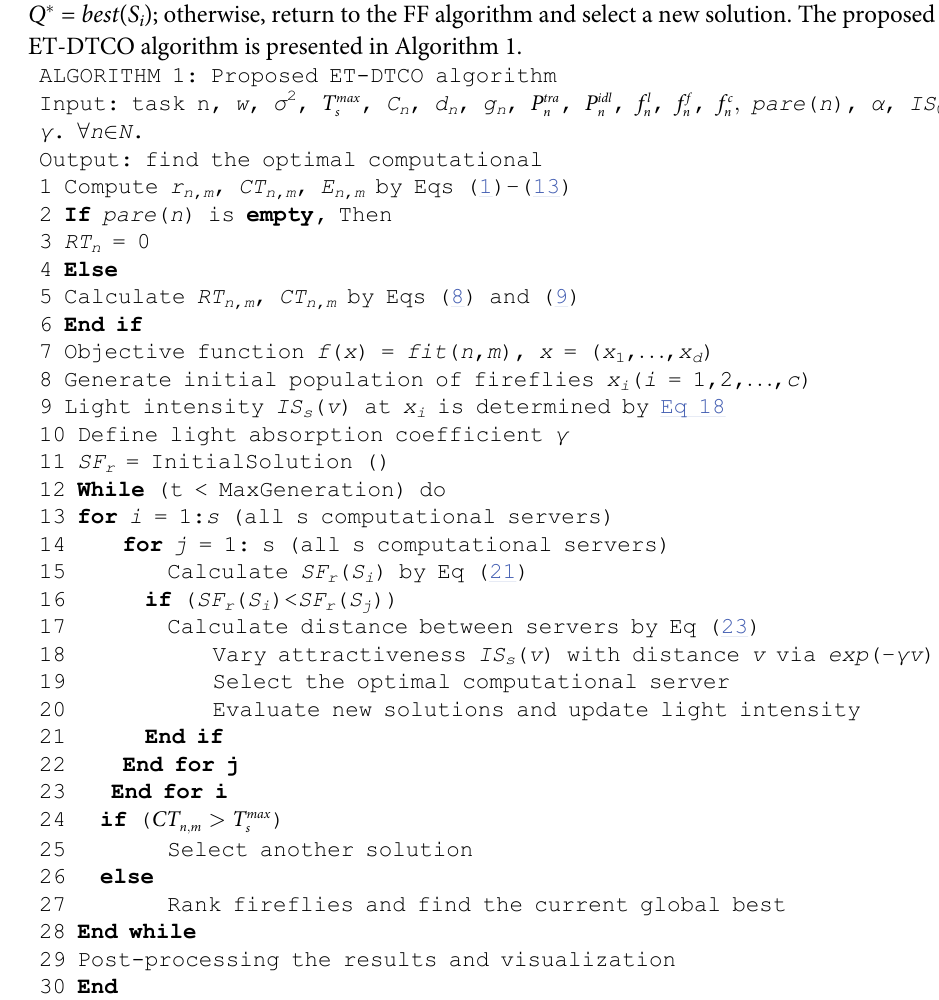
ALGORITHM 1: Proposed ET-DTCO